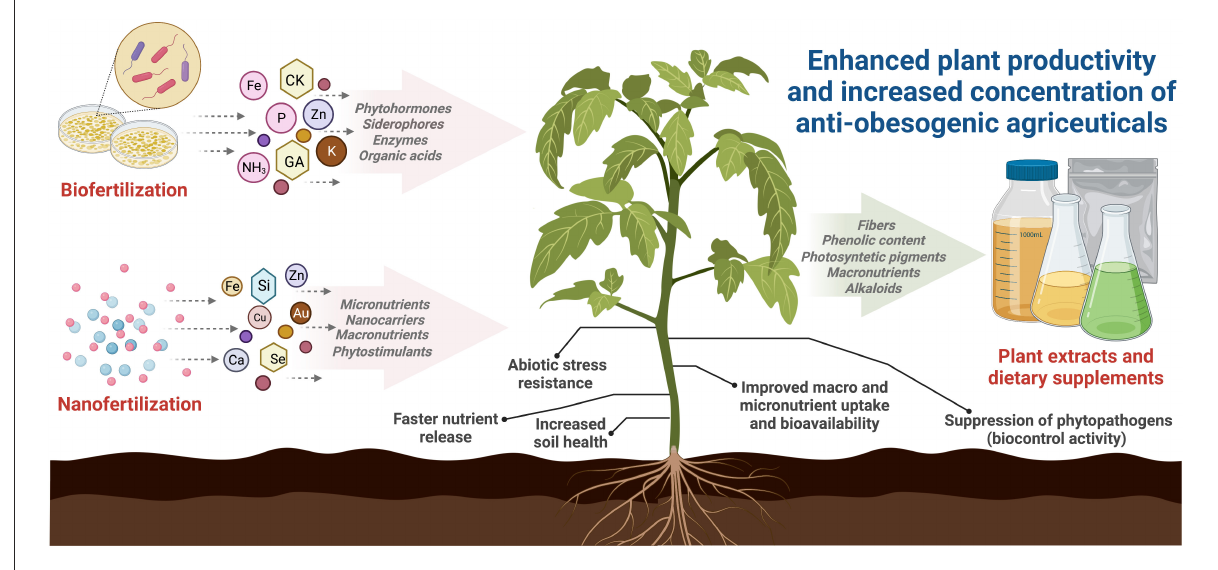
FIGURE3 Proposed sustainable strategies to enhance plant productivity and increase the concentration of anti-obesogenic agriceuticals.